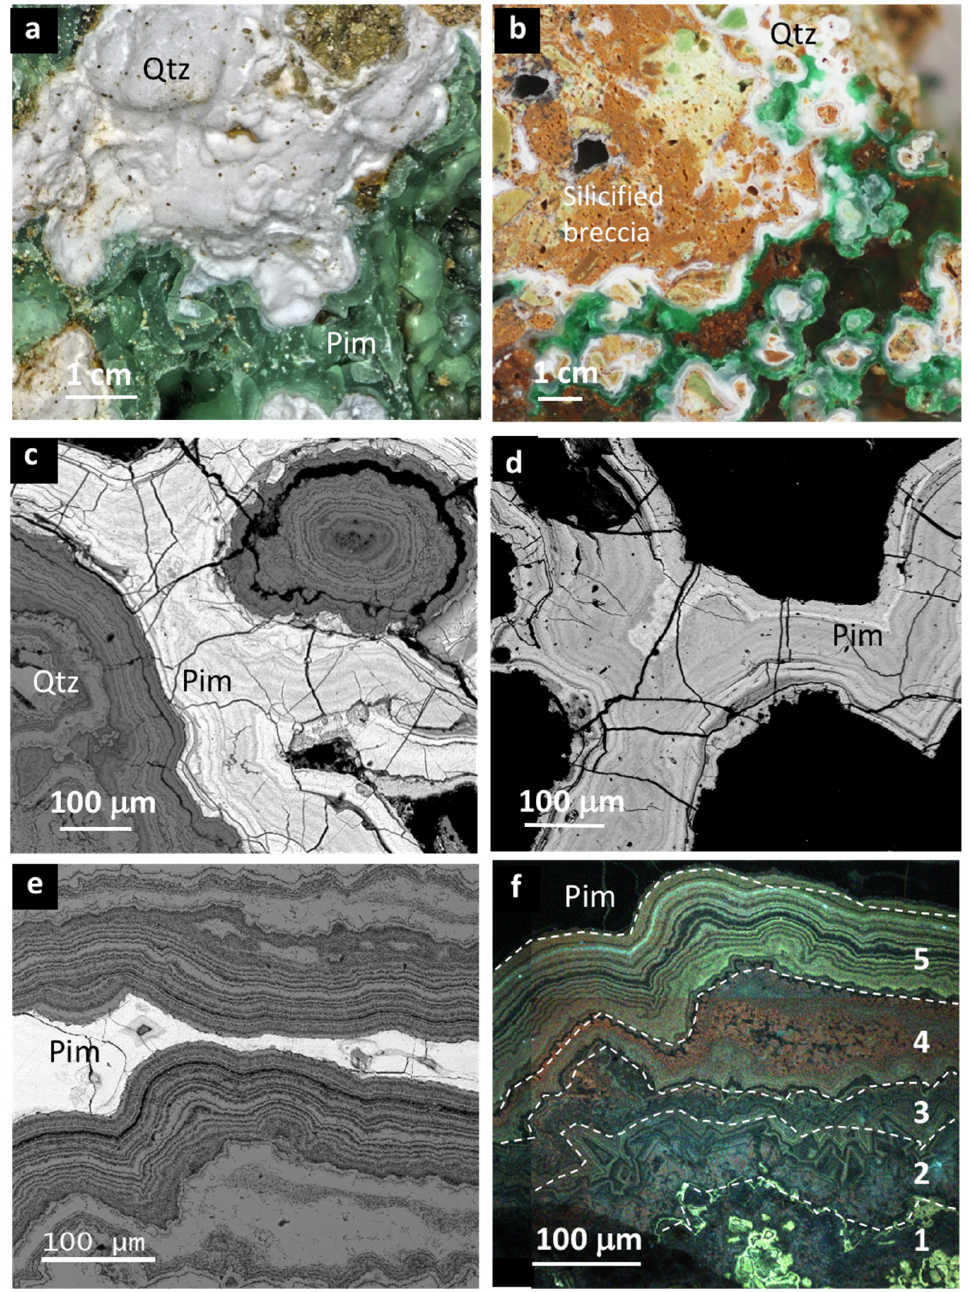
Figure 4. ( a ) Ni-silicate (pimelite, noted Pim) crystallised on white quar tz (Q tz ). ( b ) Pimelite on white quar tz cementing silici fi ed clasts. ( c ) BSE image showing the rims of quar tz fl owed by pimelite. ( d ) Detail of the chemical zoning in the pimelite colloform textures. ( e ) White quar tz observed by BSE, showing a decreasing size of crystals; ( f ) Cathodoluminescence image showing white quar tz rims from 1 (earliest rim) to 5 (colloform quar tz ).